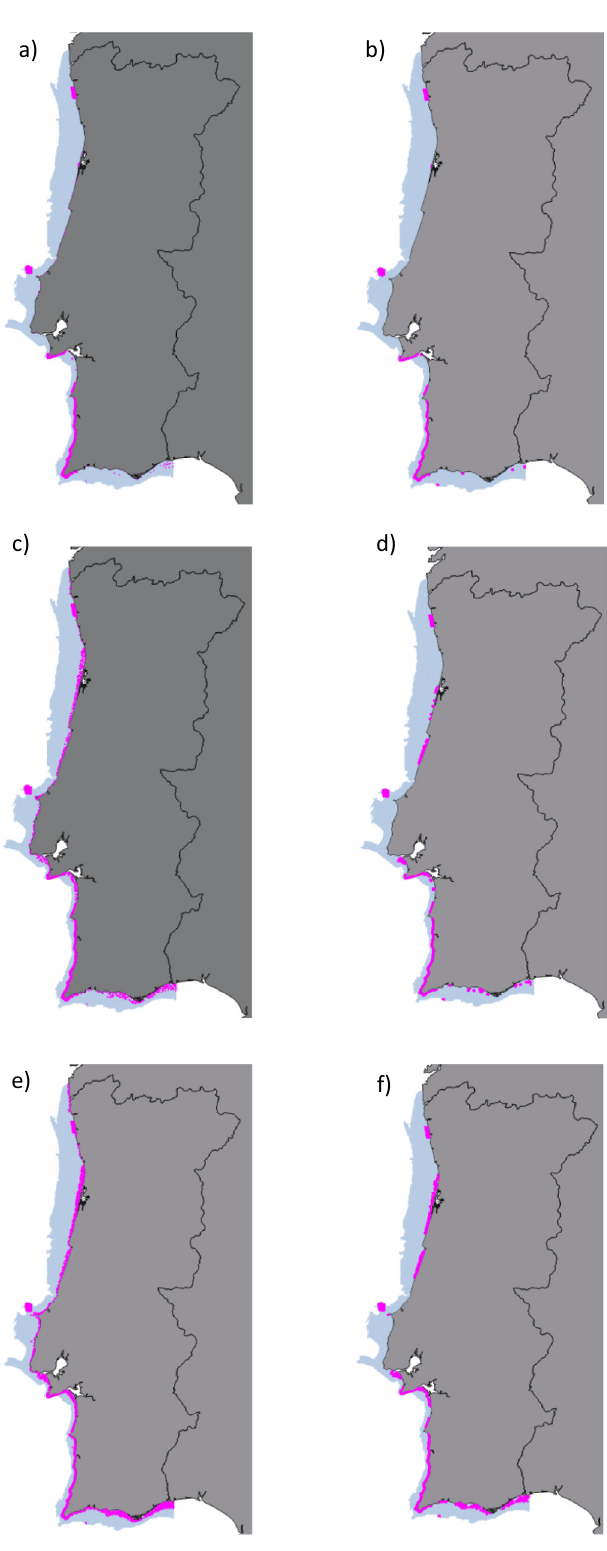
Fig. 2. Results of the solutions provided by Marxan (a, c, e) and MinPatch solutions (b, d, f) for the 10%, 30% and 50% conservation scenarios. Protected areas are shown in